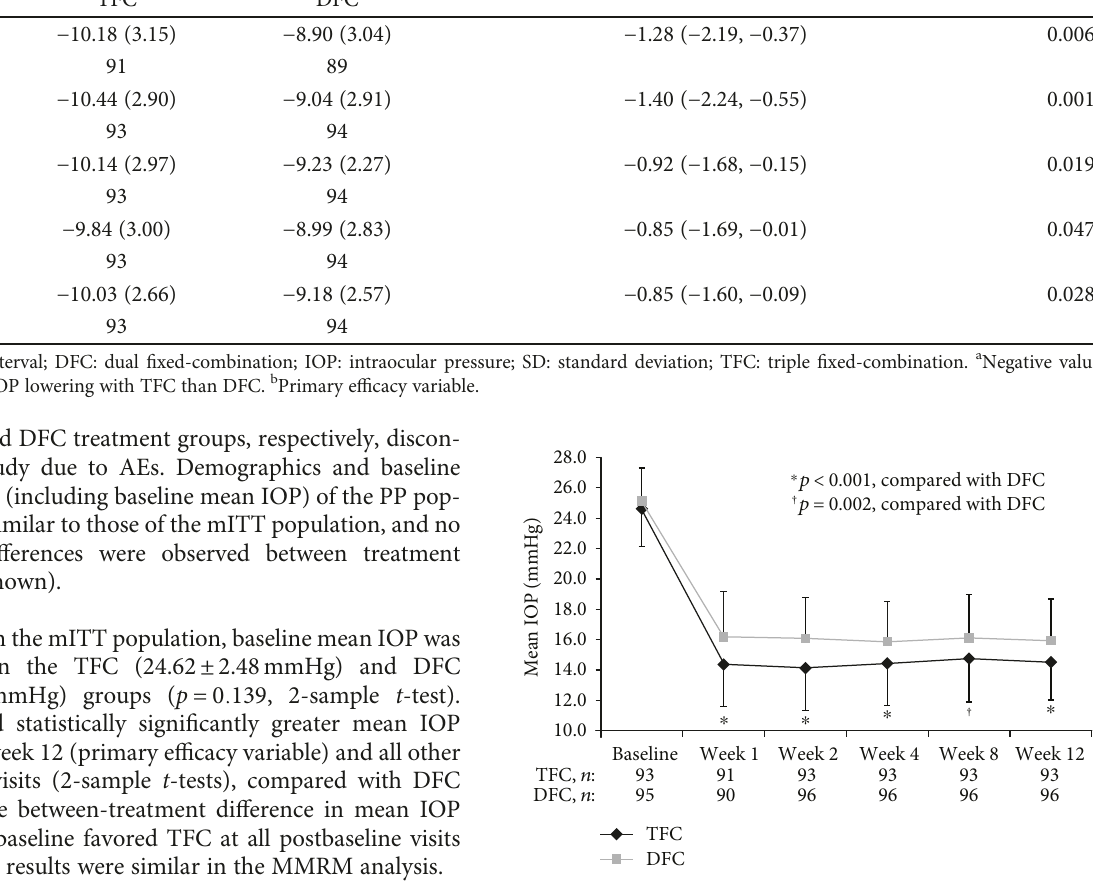
Table 2: Mean IOP change from baseline in the modi fi ed intent-to-treat population (2-sample t -test). Mean IOP change from baseline Visit (SD), mmHg Between-treatment di ff erence a (95% CI), mmHg p value